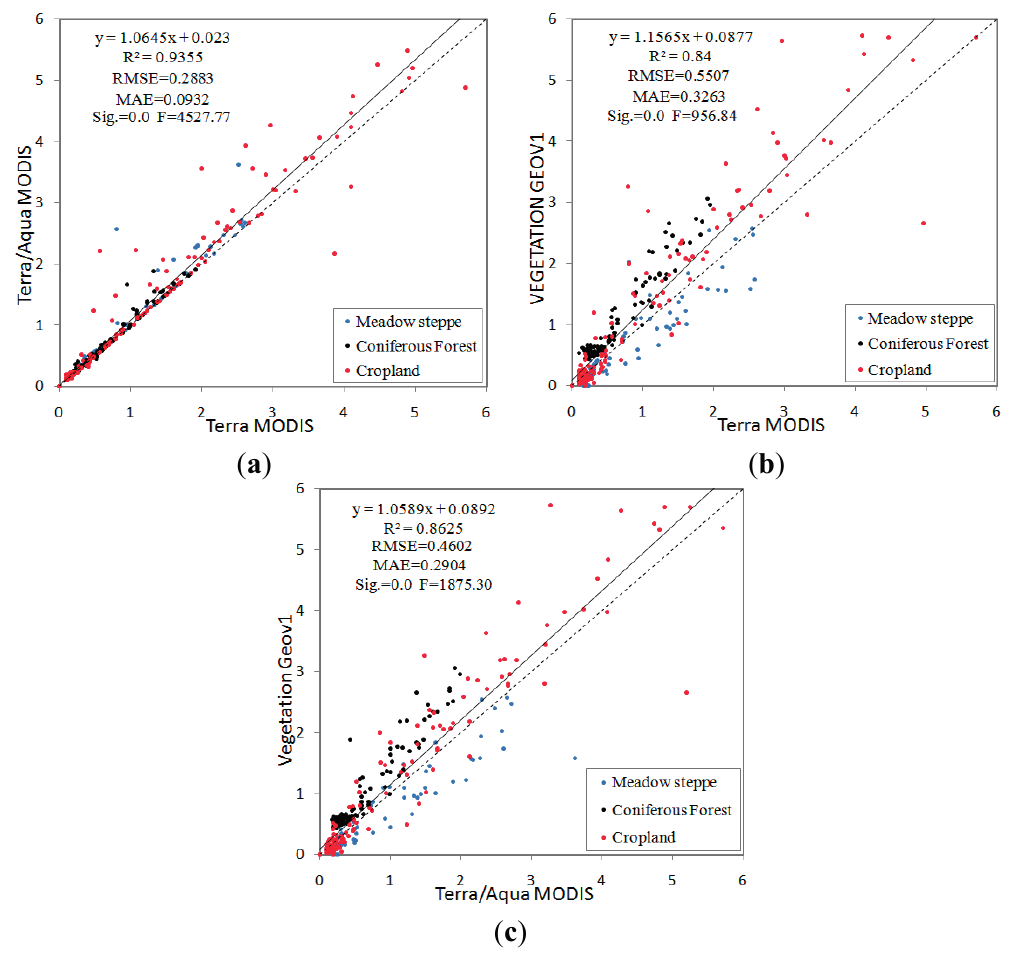
Figure 4. Intercomparison of LAI products: ( a ) Terra MODIS vs. Terra + Aqua MODIS; ( b ) Terra MODIS vs. VEGETATION GEOV1; and ( c ) Terra + Aqua MODIS vs. VEGETATION